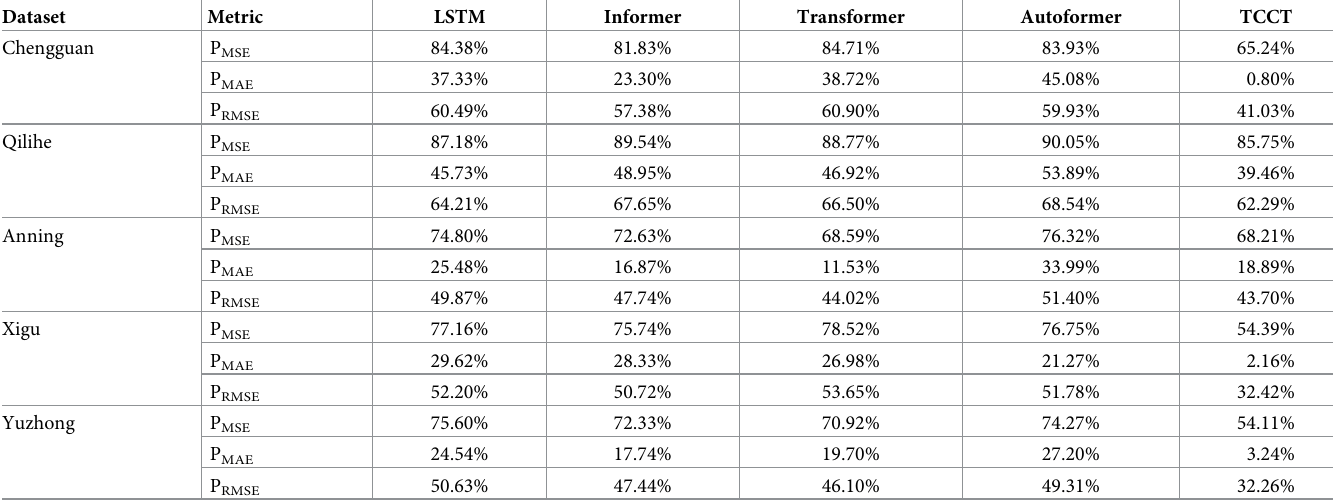
Table 4. Improvement percentages of the proposed model and baselines.